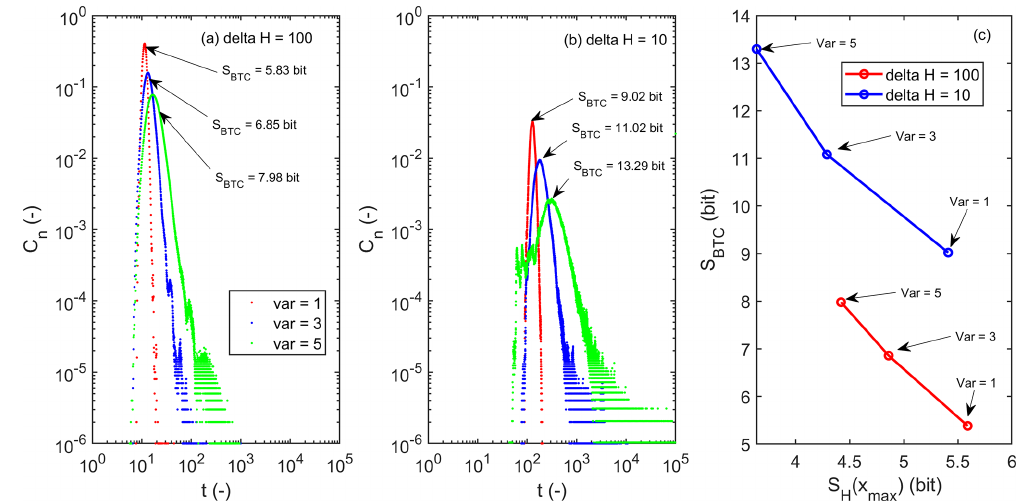
Figure 7. Breakthrough curves and their Shannon entropies S BTC for (a) (cid:49)H = 100 and (b) (cid:49)H = 10. (c) S BTC plotted against the flow path entropy of the downstream outlet S H (x max ) , before particles leave the domain, for all variance cases, and (cid:49)H = 100 and 10,